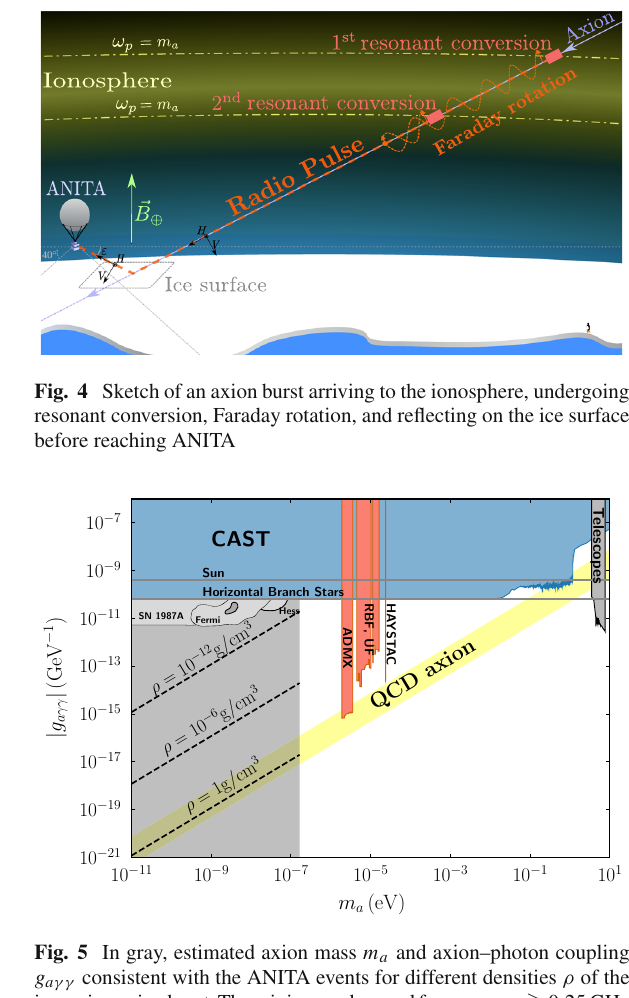
Fig. 5 In gray, estimated axion mass m a and axion–photon coupling g a γγ consistent with the ANITA events for different densities ρ of the incomingaxionburst.Theminimumobservedfrequency ω (cid:3) 0 . 25GHz forces m a (cid:2) 1 . 6 · 10 − 7 eV. We also show current experimental con- straints [57–62]. The yellow region is compatible with the QCD axion models [63] On the other hand, we can also extract information on the mass m a and coupling g a γγ of the ALP. Using Eq. (2), we can estimate the relation between the observed electric field amplitude ∼ 1 mV / m, m a , g a γγ , and the amplitude of the axion field burst a 0 . The latter can, in turn, be determined by the energy density of the burst ρ ∼ | a 0 | 2 ω 2 . Consider- ing B ⊕ ∼ 0 . 45 G [22,23], a wave frequency ω ∼ 1 . 5 GHz, attenuation due to reflection on the Antarctic ice, and typical d ω 2 p / m 2 a ∼ 10 − 2 km − 1 , we resonance-enhancement factors d z show in Fig. 5 an estimation for the values of g a γγ and m a consistent with ANITA for different energy densities ρ of the incoming axion burst. The gray region shows the mass- coupling range compatible with the minimum observed fre- quency ω ∼ 0 . 25 GHz (corresponding to m a (cid:2) 10 − 7 eV), and the dashed lines label different densities of the incom- ing axionic burst. For densities (cid:3) 10 − 12 g / cm 2 all present experimental bounds are evaded